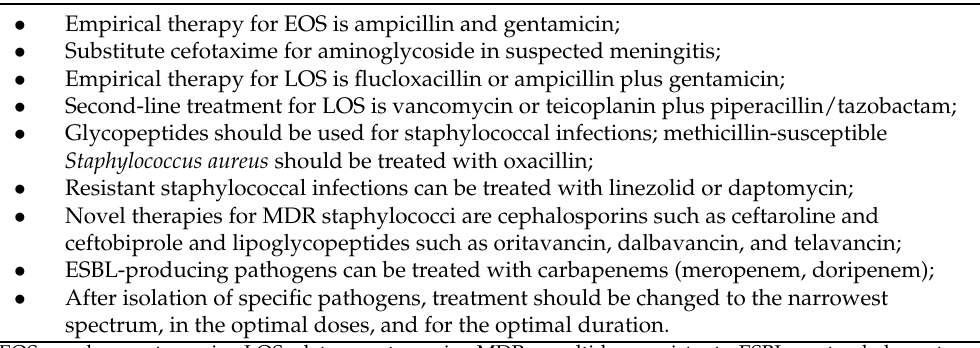
Table 3. Guidelines for antibiotic use in neonatal